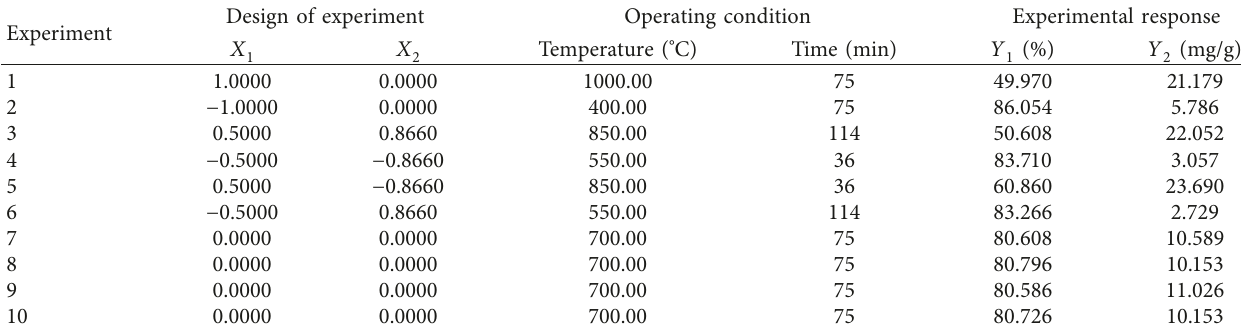
: yield and Y : MB adsorption. 1 2